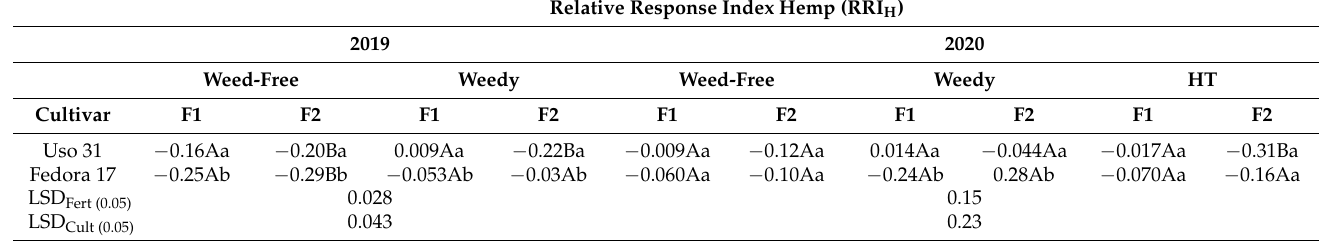
Table 5. The effect of the interaction of cultivar × fertilization × weed management on the relative response index of hemp crop across the two growing seasons 2019 and 2020. WM: weed management treatments (weed-free; weedy; HT: herbicide-treated); C: cultivars (Uso 31; Fedora 17); F: fertilization treatments (F1: 70 kg ha − 1 ; F2: 140 kg ha − 1